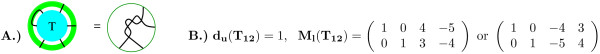
A.) The 2-string tangle T12. This 2-string tangle is obtained from the 3-string tangle, T, by connecting endpoint arcs x1 and x2. B.) The coloring invariants corresponding to the 2-string tangle T12.